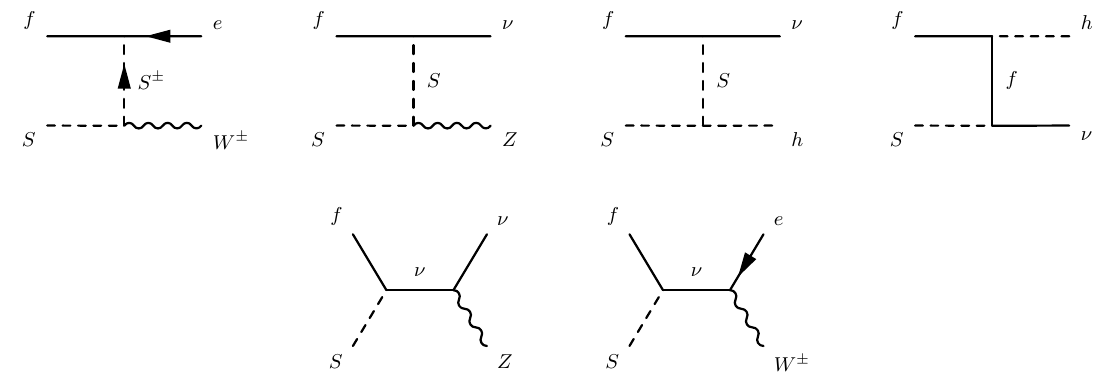
Figure 21 . Diagrams contributing to co-annihilation of f with S